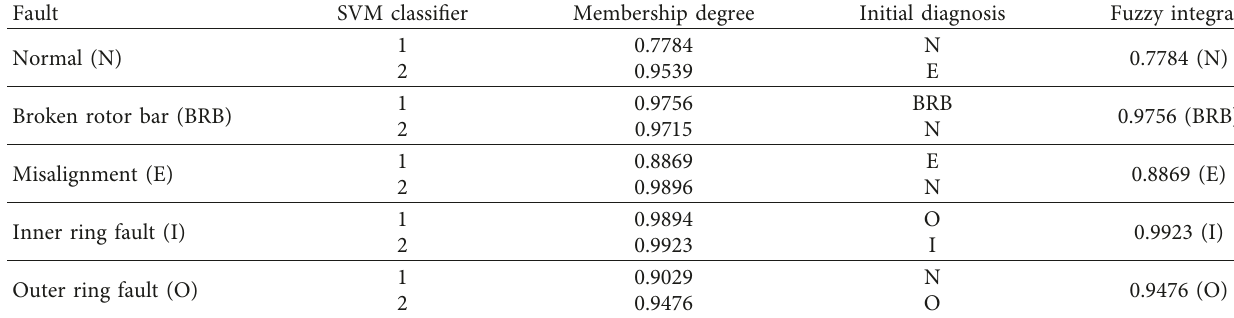
Table 11: Diagnosis results of fuzzy integrals.